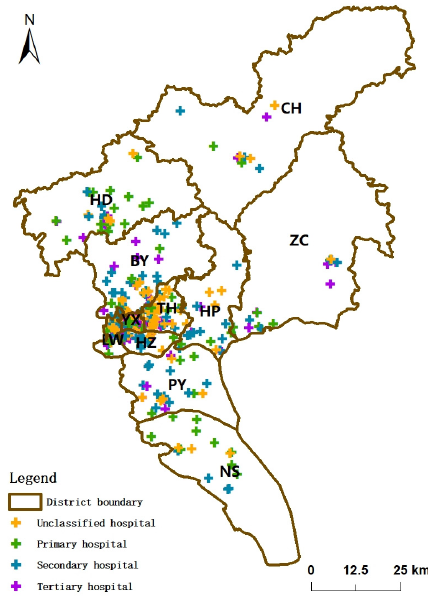
Figure 1. Distribution of hospitals in